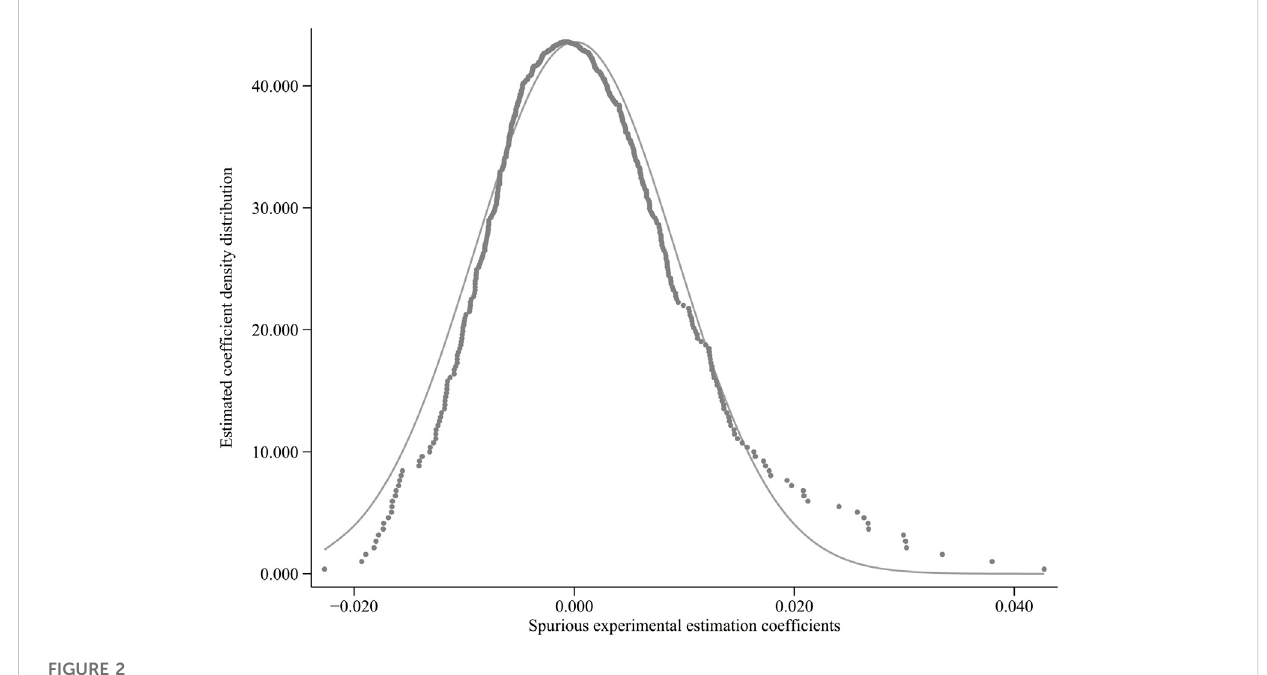
FIGURE 2 Placebo test graph.